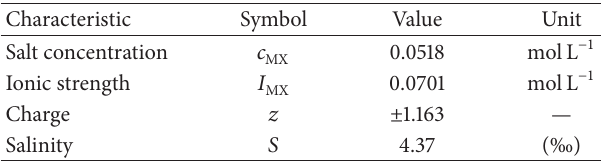
Table 6: Main parameters of the Single Saliva Salt (MX) for the inorganic components of synthetic saliva, according to SALMO model.